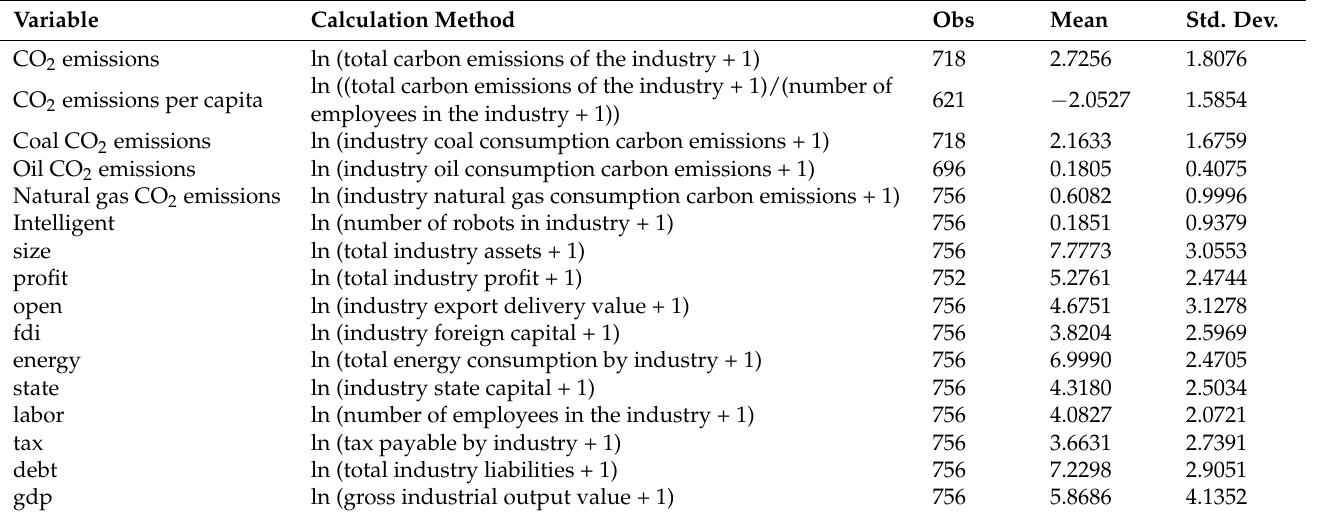
Table 1. Descriptive statistics of main